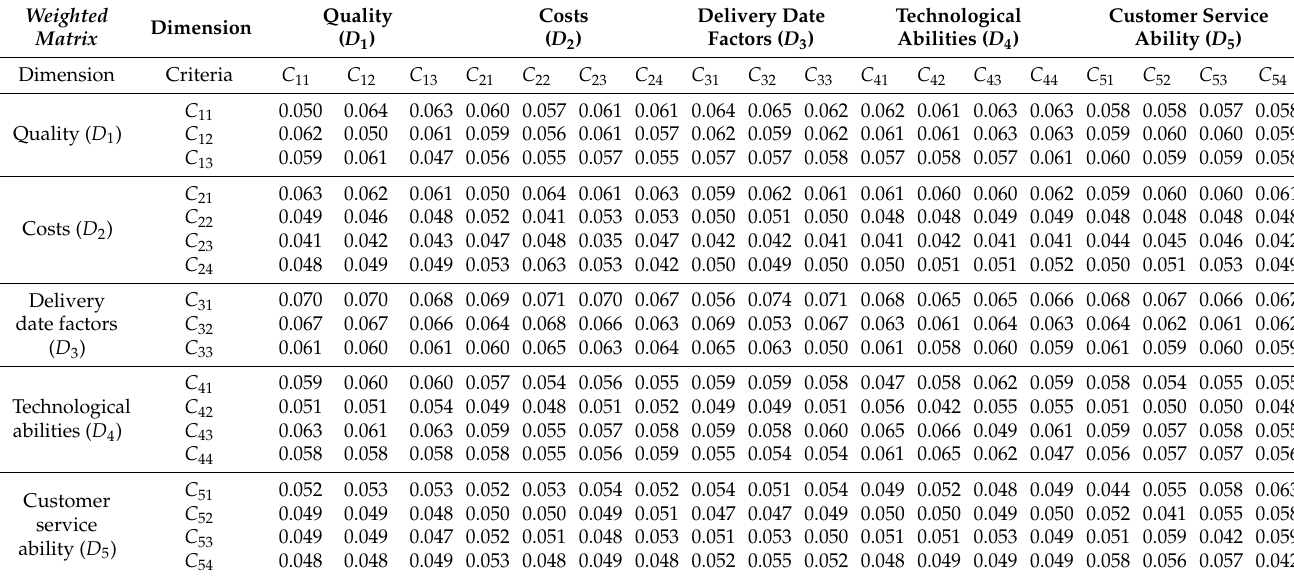
Table 9. D-ANP weighted supermatrix.